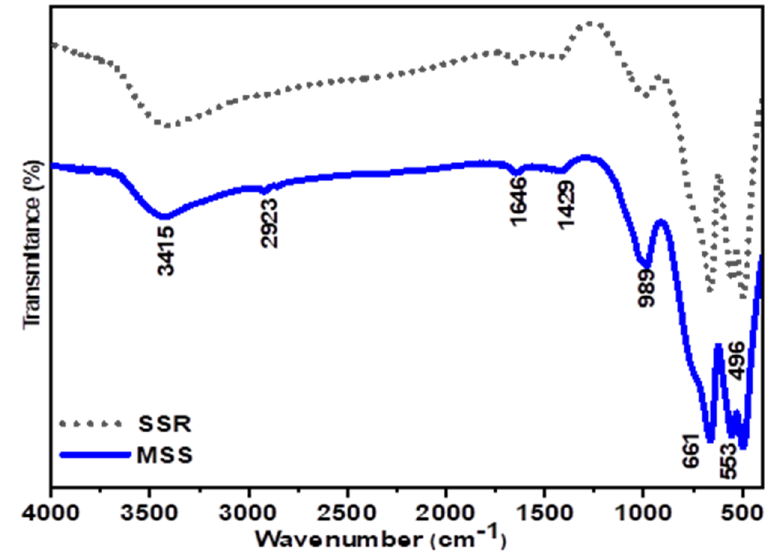
Fig. 5. FTIR spectra of zinc aluminate samples synthesized by both SSR and